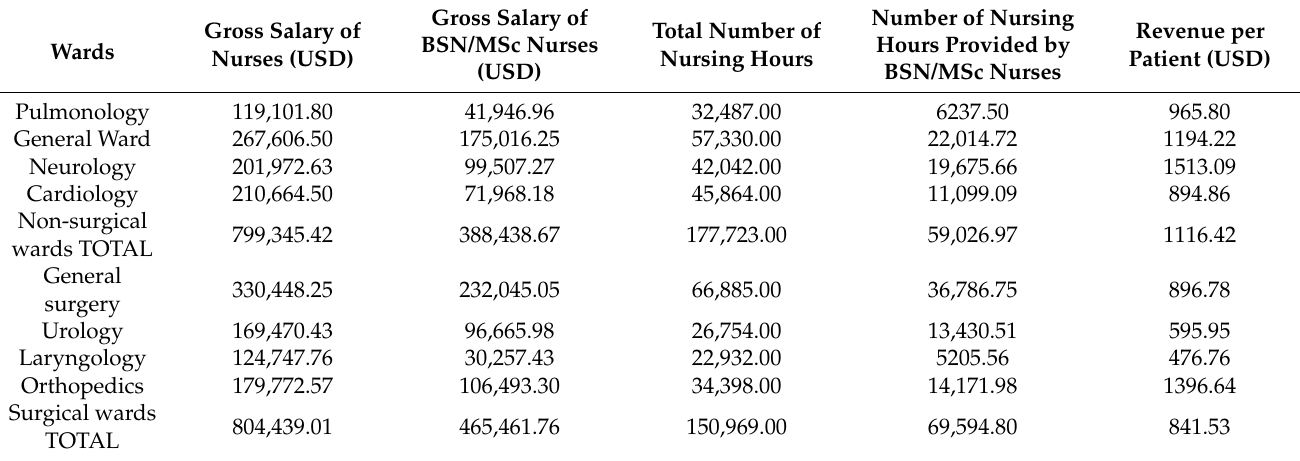
Table 2. Costs and revenue and number of nursing hours, including BSN/MSc nurses in non-surgical and surgical